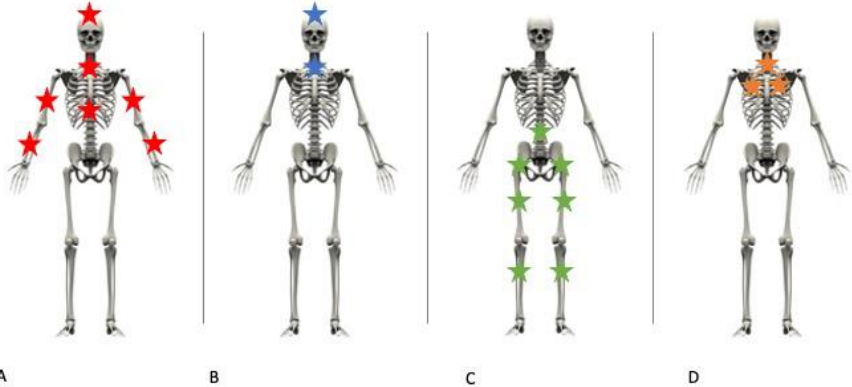
Figure 1. Lesions’ distribution in case of falls onto the head with ( A ) and without ( B ) defense attempt, falls on to the feet ( C ) and in our case ( D ).